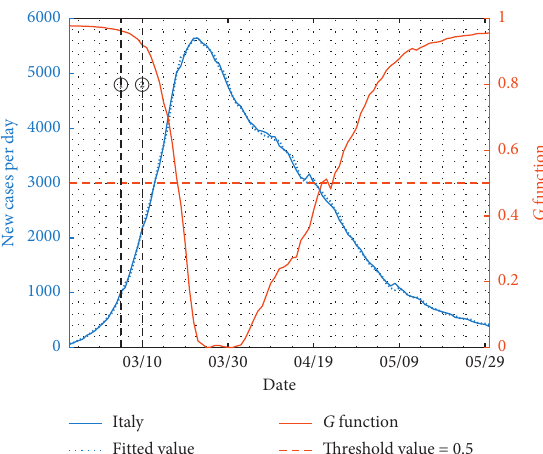
Figure 3: The fitting result of Italy. The left axis shows the daily confirmed cases for the real data after smoothness (blue solid line) and its fitted values by the STAR model (blue dashed line). The right axis shows the value of nonlinear functions G changing with time (orange solid line) and the reference line with threshold 0.5 (orange dashed line). The vertical dotted line indicates the sequential released policies: ① close schools across the country and ② nationwide lockdown.